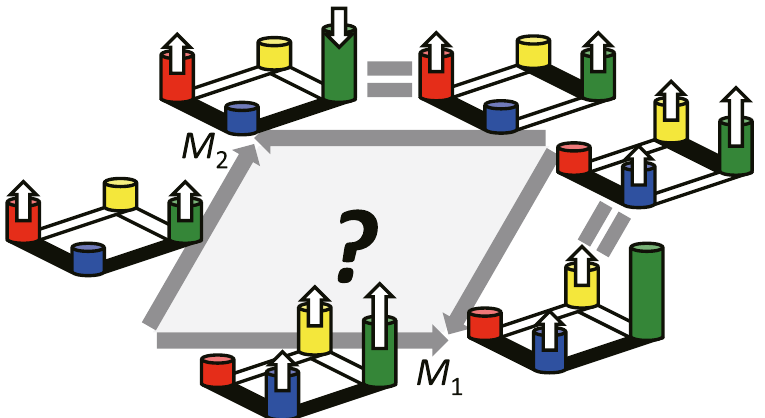
Figure 2 . The schematic picture of the analysis studying the (2 , 2) model using the (1 , 1 , 1 , 1)